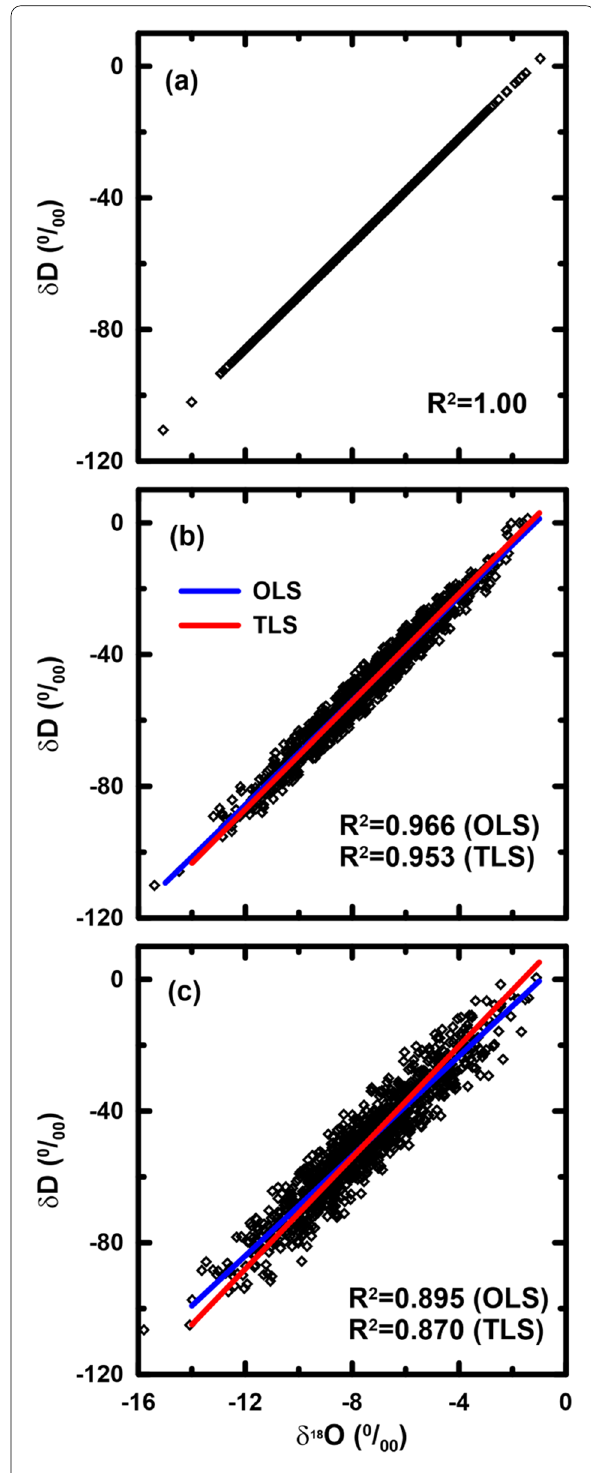
Fig. 4 Results of a Monte Carlo experiments. a Global Meteoric Water Line (GMWL) of oxygen and hydrogen isotopes with mean values and one standard deviation; the values were 7.5 2.21 − ± and 50.1 17.65, respectively. b New data set generated from the − ± distribution from the previous one (means values with one standard deviation for oxygen and hydrogen, 7.5 2.23 and 50.2 17.90). − ± − ± c Another data set, means values with one standard deviation for oxygen and hydrogen, 7.5 2.25 and 50.2 − ± − ±